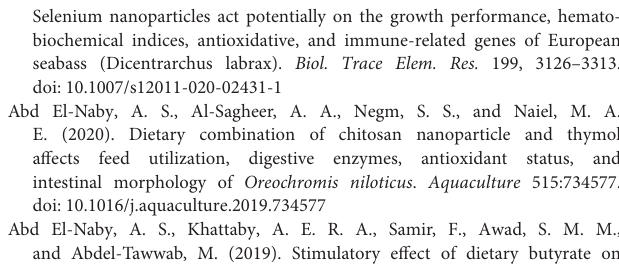
Figure 1 | Kidney of control fish (T0). Figure 2 | Kidney of fish treated with 1 mg/kg SiNP (T1). Figure 3 | Kidney of fish treated with 2 mg/kg SiNP (T2). Figure 4 | Kidney of fish treated with 3 mg/kg SiNP (T4). Figure 5 | Liver of control fish (T0). Figure 6 | Liver of fish treated with 1 mg/kg SiNP (T1). Figure 7 | Liver of fish treated with 2 mg/kg SiNP (T2). Figure 8 | Liver of fish treated with 3 mg/kg SiNP